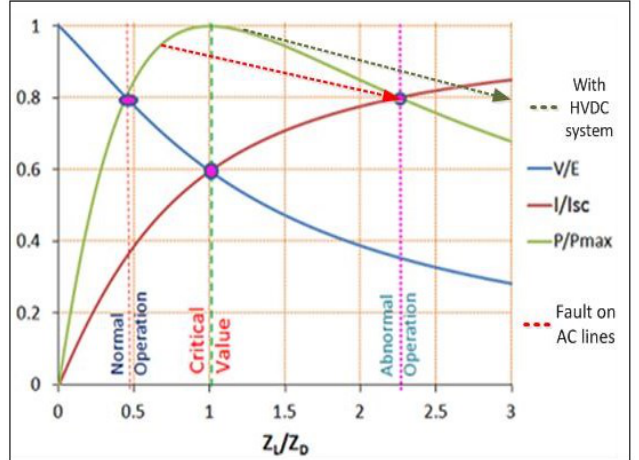
Fig. 1. Receiving end voltage, current and power as a function of load with HVDC